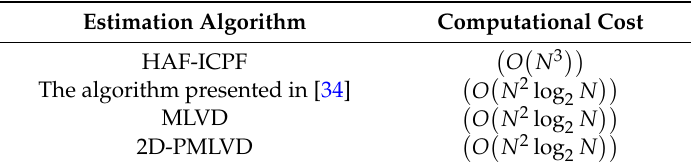
Table 1. Computational Cost. Estimation